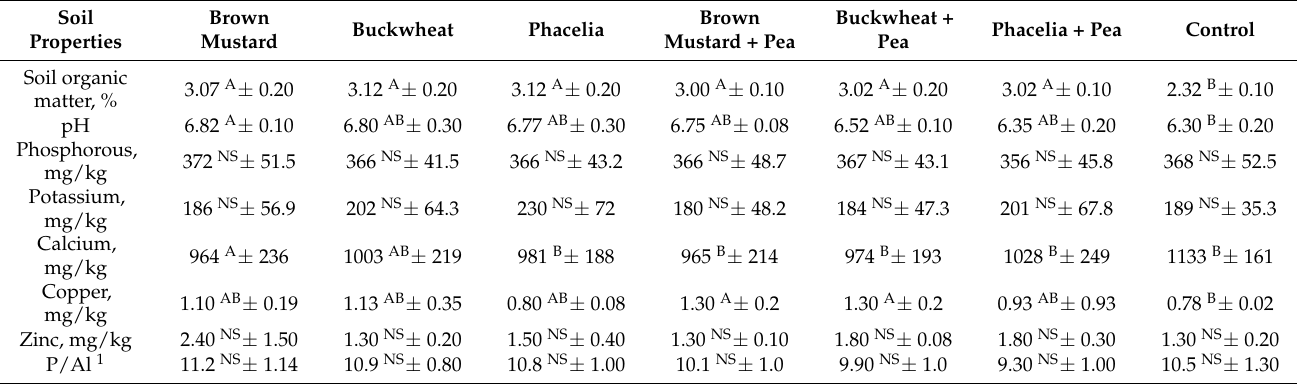
Table 5. The post-experiment analysis of variance (ANOVA) generated mean values of concentration of soil health indicators accompanied by standard deviation and Tukey’s mean separation least significant difference (LSD) letters (i.e., A, B, C, etc.) for the greenhouse experiment. The means labeled with different LSD letters are significantly different from one another. A non-significant effect of experimental treatments on soil health indicators is labeled as